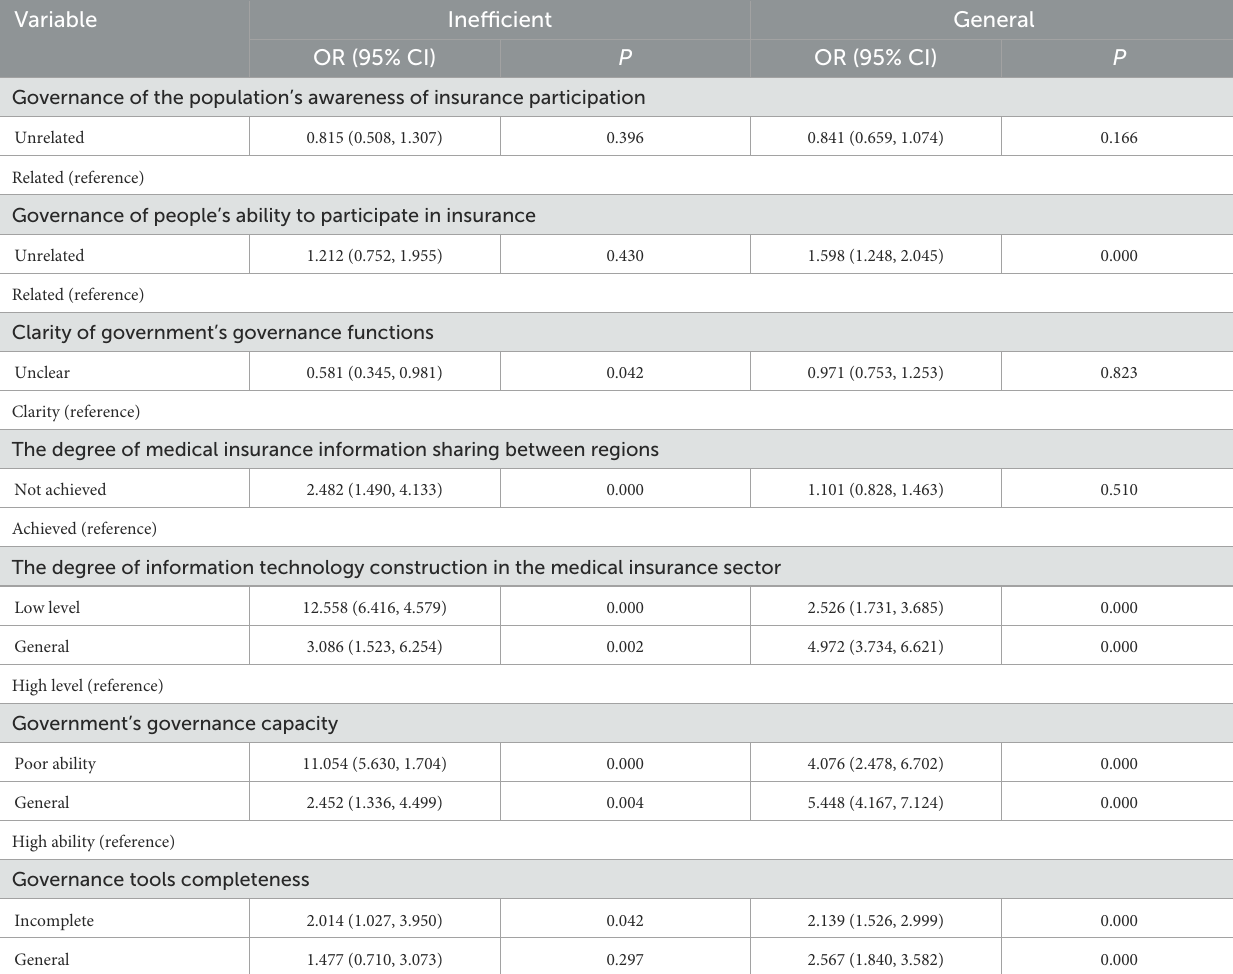
TABLE 5 Analysis of results classified according to explaining variable 3—logistic regression analysis ( n = 1,975).